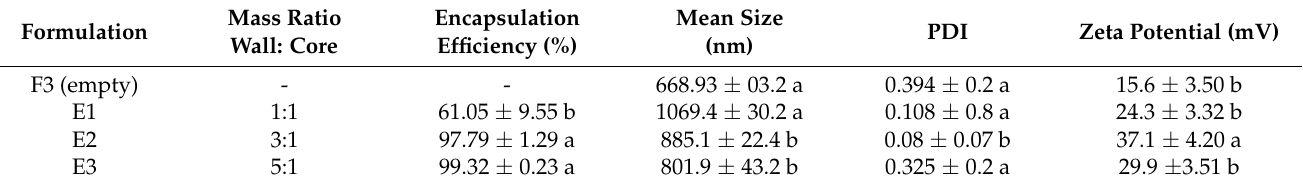
Table 3. Encapsulation efficiency, mean size, PDI, and zeta potential of orange essential oil loaded SPECs.